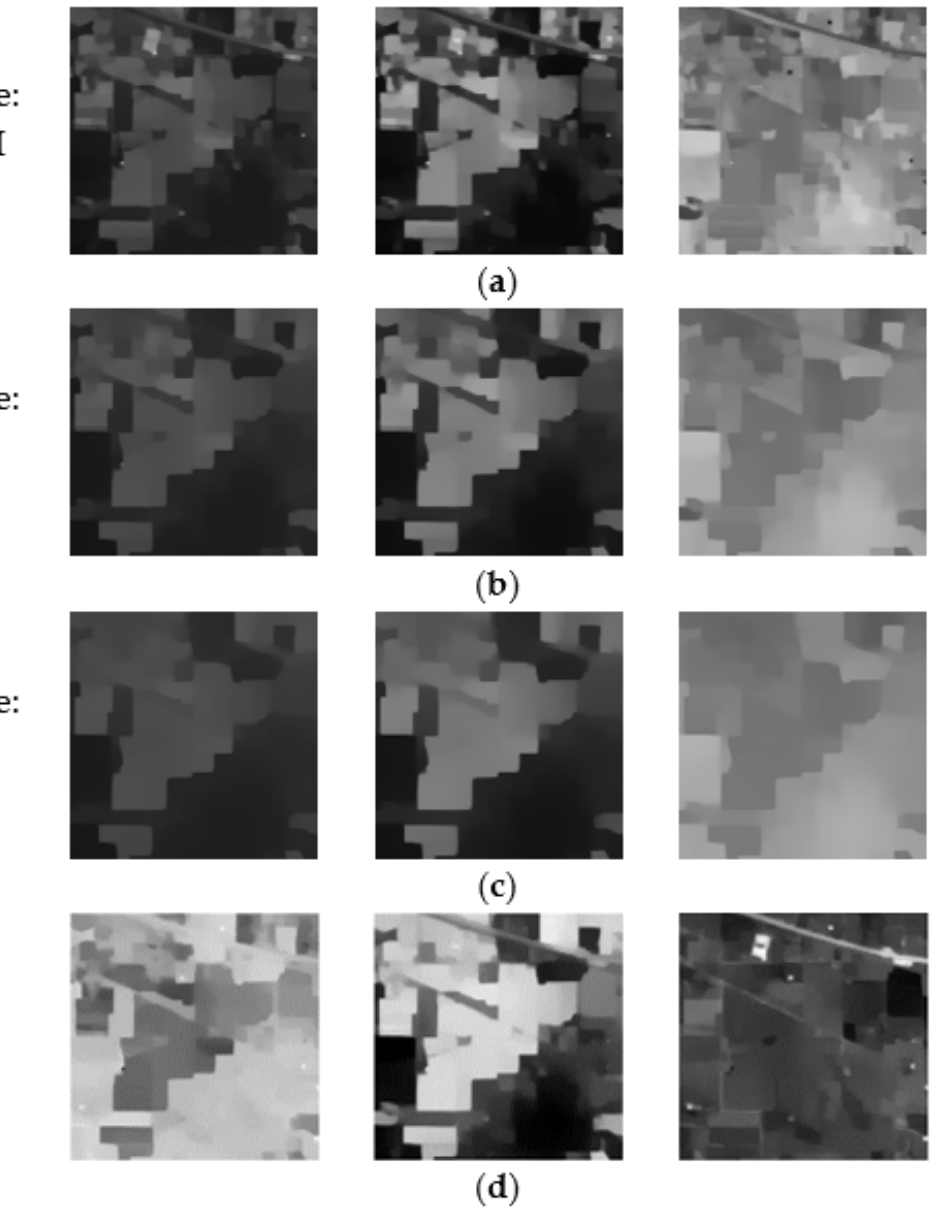
Figure 7. Indian Pines dataset. The results of models under different parameters, which ( a ) 𝜆 (cid:2869) = ( b ) λ 1 = 0.01, ( c ) λ 3 = 0.02, ( d ) λ i = 100. Each row represents the first, the third, and the fifth dimension 0.004 , ( b ) 𝜆 = 0.01 , ( c ) 𝜆 = 0.02 , ( d ) 𝜆 = 100 . Each row represents the first, the third, and the fifth (cid:2869) (cid:2871) (cid:3036) single-band image of the corresponding results from left to dimension single-band image of the corresponding results from left to right.